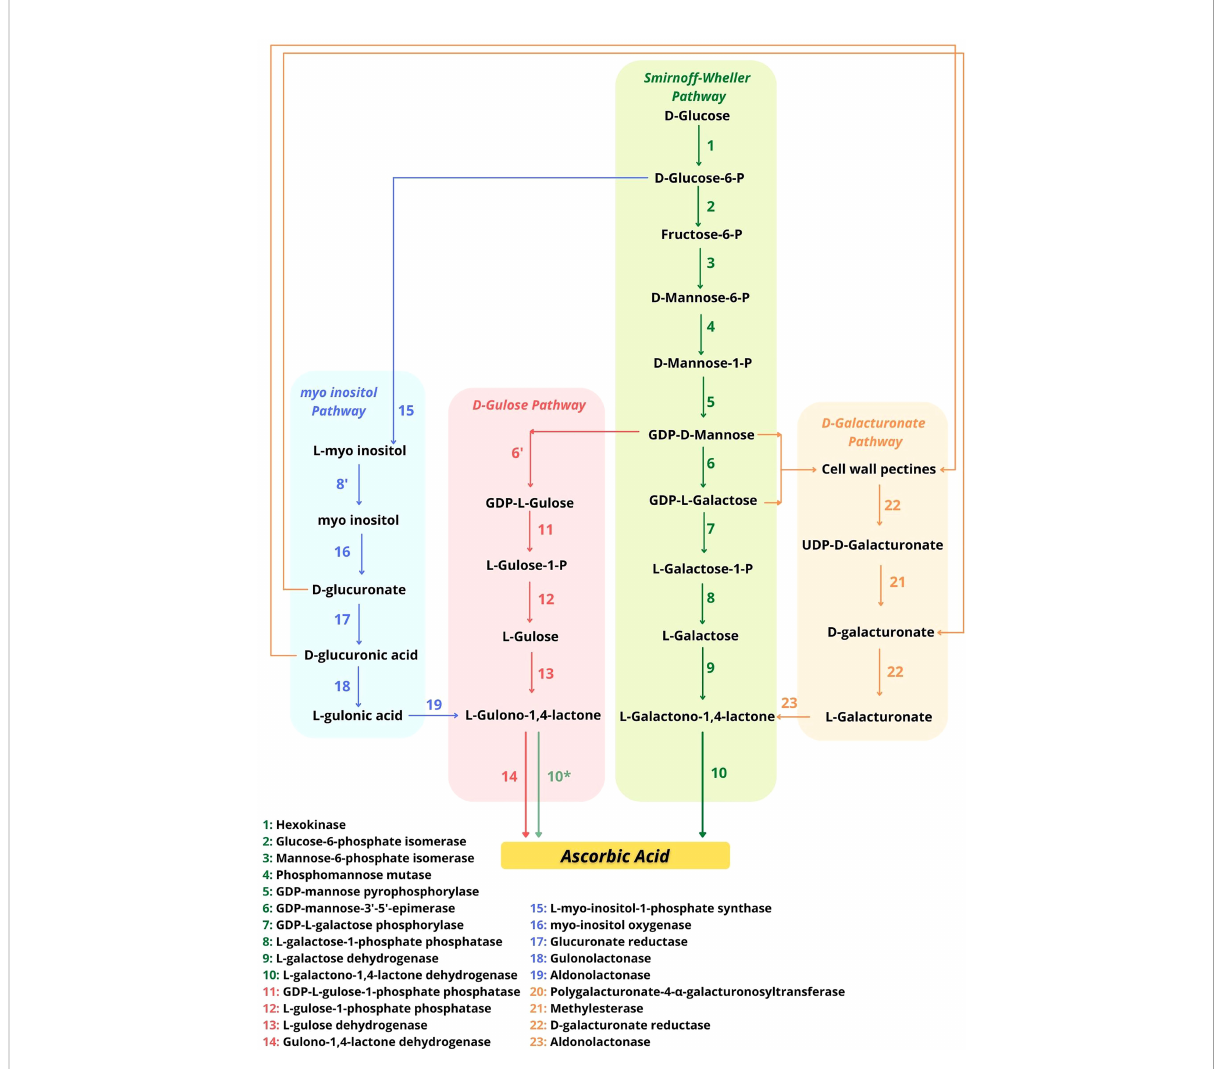
FIGURE 2 Possible pathways for AsA synthesis in plants indicating the potential interaction points. Adapted from Smirnoff (2018). The possibility that L -GalLDH uses L -GulL as a substrate to form AsA (Leferink et al., 2008) is indicated with an asterisk (*) in the D -Gulose